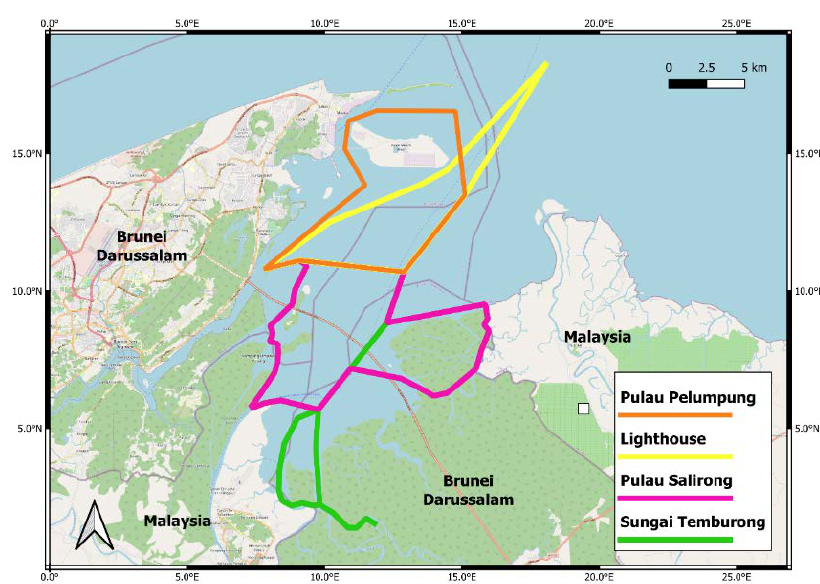
Figure 2. The planned routes for boat survey in the Bay of Brunei, Brunei Darussalam. While sighting rate is measured as below: The surveys were conducted only during the day, starting at 8.00 am and ending at 4.00 pm. Four observers were on a 10 m long wooden speedboat with an average speed Total number o f sighting × Sighting rate = Total survey e f f ort ( km . h ) MIN GPSMAP 78 s Global Positioning System (GPS) receiver. One of the four observers the left and right of the boat, while the other observer sat at the back of the boat near the boatman. The observers were aided with NIKON© marine binoculars 7 × 50 WP compass the boat’s position was marked in the GPS and recorded on a datasheet. An expert then determined the species on the boat with the naked eye.